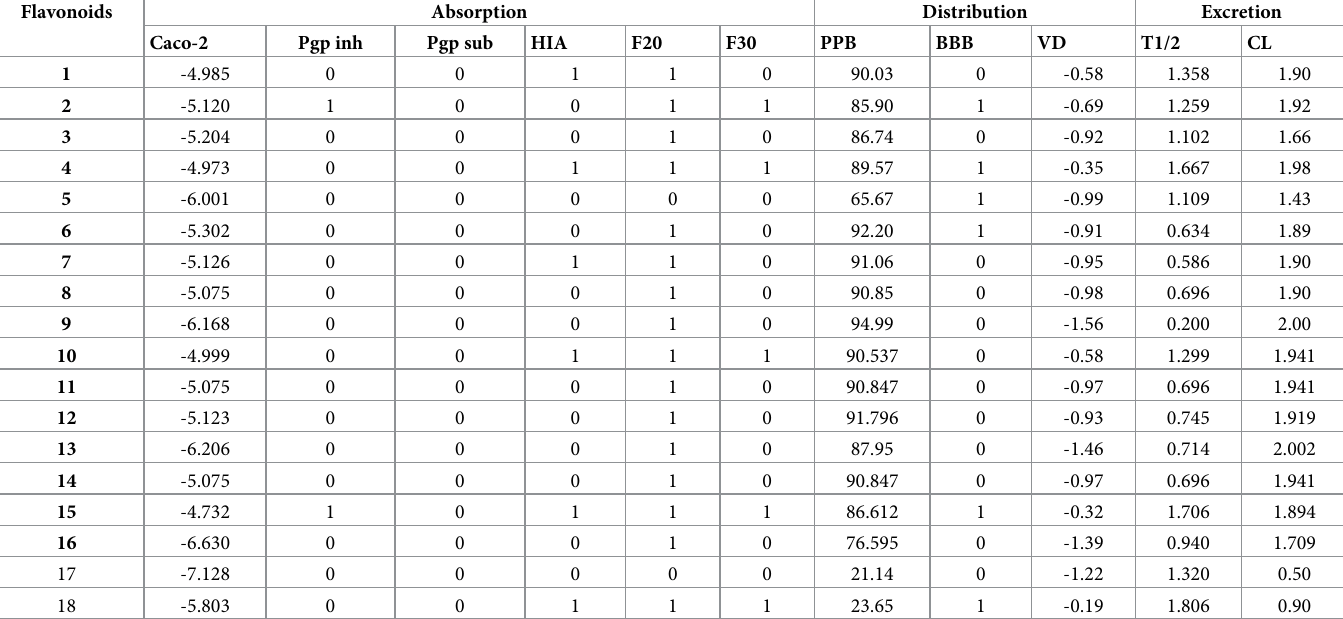
Table 3. Absorption, distribution and excretion parameters of the flavonoids and the two controls.